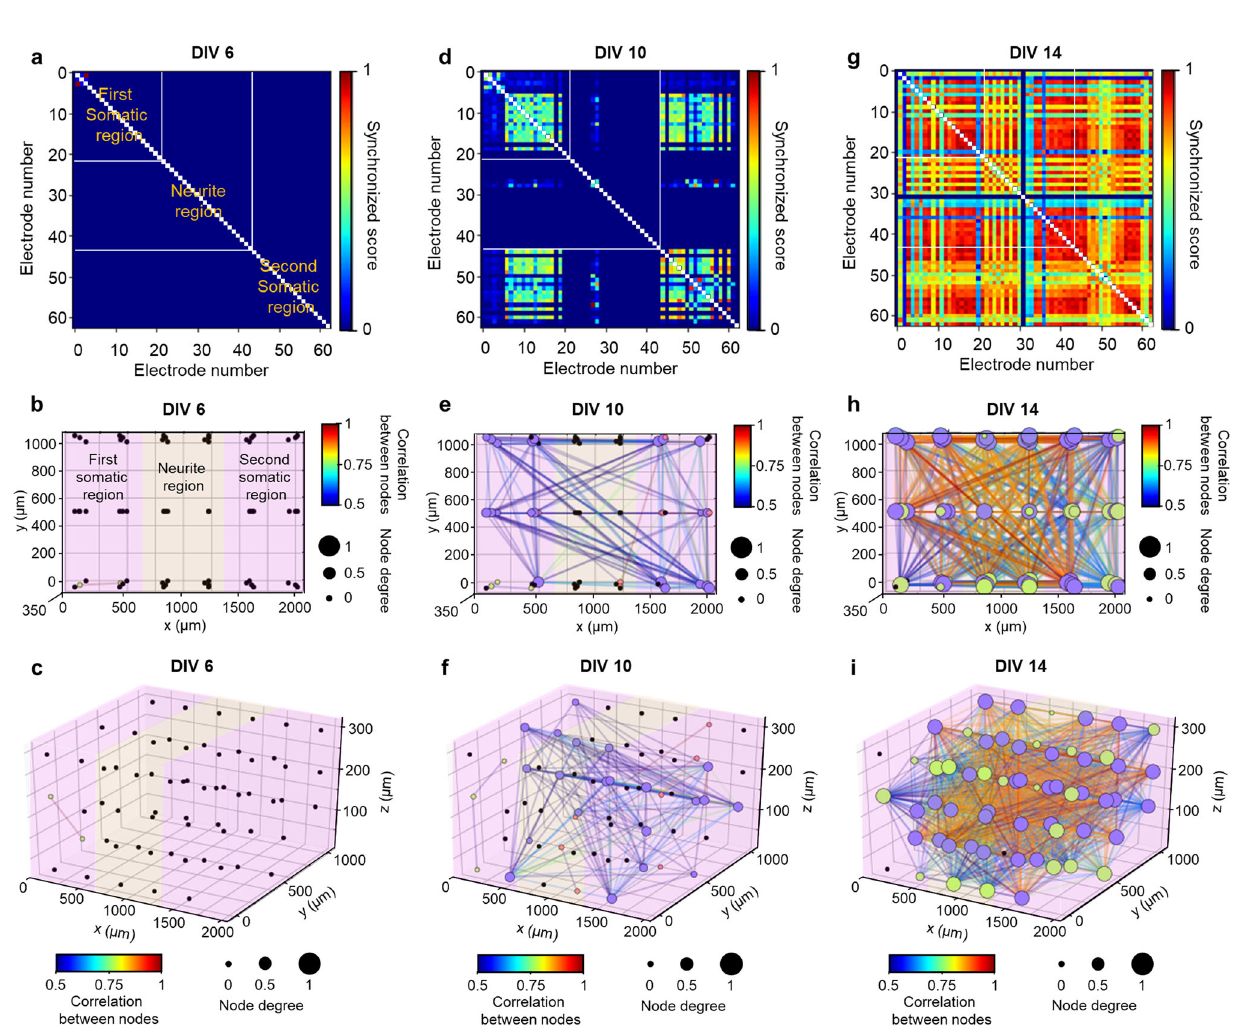
Fig. 6 Temporal evolutions of neural network dynamics in the compartmentalized two-group 3D neural network model. Color-mapped cross-correlation matrices displaying synchronized scores between electrodes ( a , d , and g ), top-down view ( xy -plane; b , e , and h ) and 3D view ( c , f , and i ) of network maps showing connectivities with node degrees, as well as correlations between nodes, based on neural activities by optical stimulation at days in vitro (DIV) 6 ( a – c ), 10 ( d – f ), and 14 ( g – i ). Node color, degree, and line color indicate network index connected among electrodes, the number of connected electrodes from each electrode, and the correlation between electrodes, respectively. Source Data is available as a Source Data fi le for Fig. 6a –